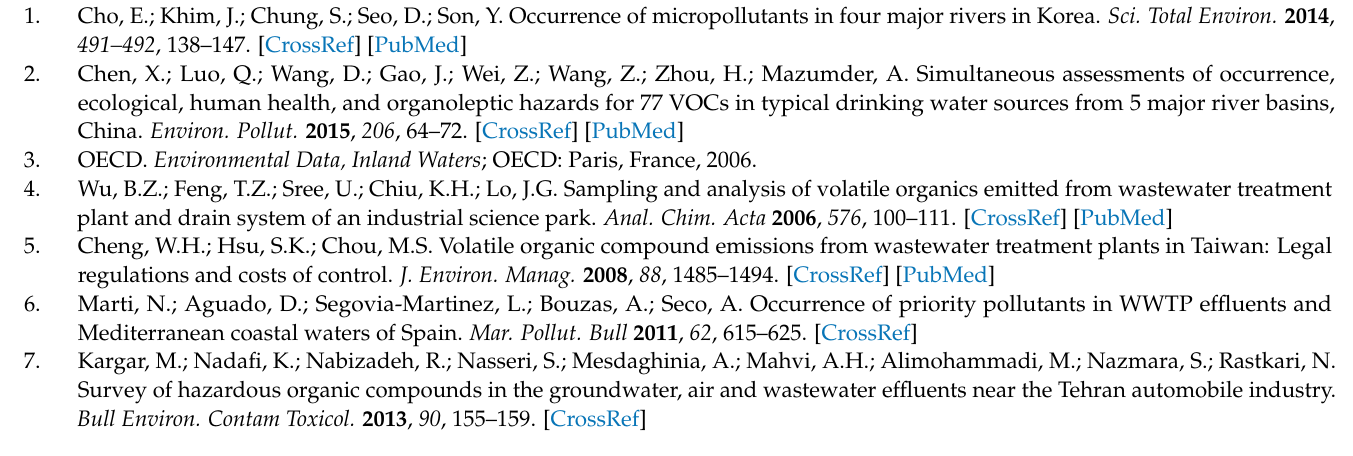
Physical and chemical properties of VOCs, Table S2: Sampling sites information, Table S3: Sewage/ wastewater treatment plants information, Table S4: Water quality data at the sampling sites, Table S5: The P&T-GC/MS conditions, Table S6: SIM parameters for the analysis of VOCs, Table S7: Accuracy of spiked test sample measurements, Table S8: Linearity, MDL, and LOQ for spiked test samples, Table S9: Water quality guidelines for VOCs, Table S10: Summary statistics for VOCs analyzed in the sampling sites at Han River Basin, Table S11: Aquatic toxicity data and PNEC values of VOCs on aquatic